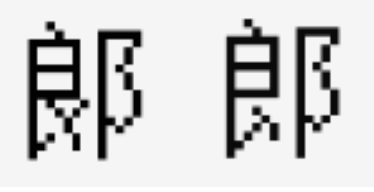
Figure 13. Stand-alone CNN | 1 Scratch misclassifies the sample on the left, whereas stand-alone misclassifies the sample on the right. Both of them also misclassify the sample in Figure